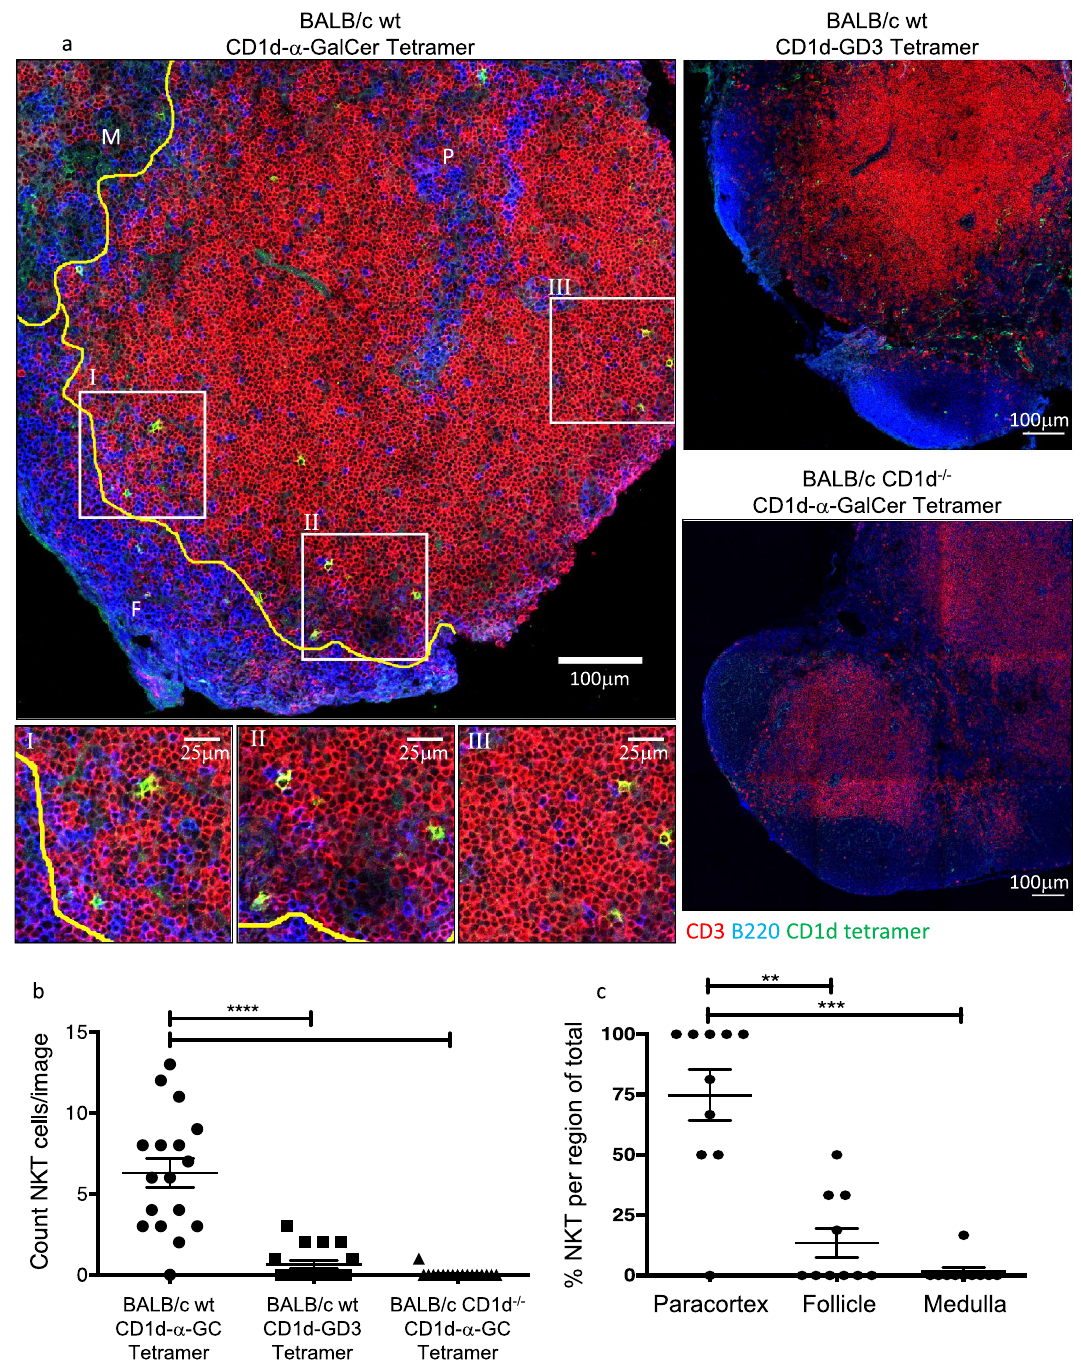
Figure 2. Distribution of NKT cells within the mouse Lymph Node. Sections of brachial lymph nodes from BALB/c WT mice stained with α-GalCer- or GD3-loaded CD1d tetramers and anti-B220 and CD3 antibodies. ( a ) Representative image showing CD1d-α-GalCer tetramer (green), B220 (blue) and CD3 (red) staining within lymph node follicle (F), paracortex (P) and medulla (M), scale bar 100 μm, with corresponding zoomed regions of interest, scale bar 25 μm. ( b ) Total count of NKT cells per 0.63 mm 2 image and, ( c ) proportion of cells